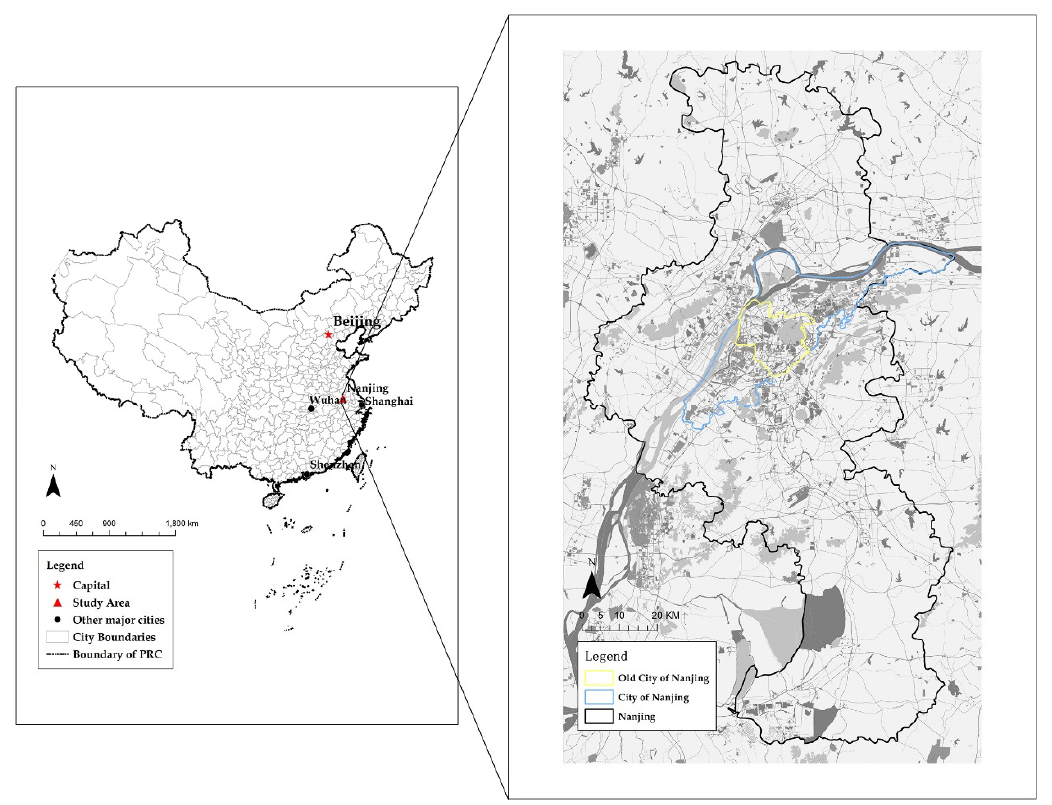
Figure 1. The Location of Nanjing City ( left ) and the illustration of study area ( right ).